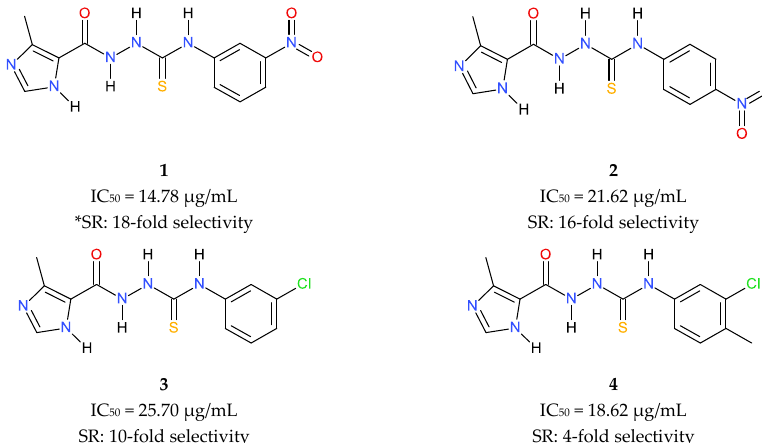
Figure 1. Structures of previously reported imidazole-thiosemicarbazides with potent inhibitory activity against the proliferation of Toxoplasma gondii [19]. *SR—selectivity ratio; defined as the ratio of the 50% cytotoxic concentration (CC 50 ) to the 50% antiparasitic concentration (IC 50 ).